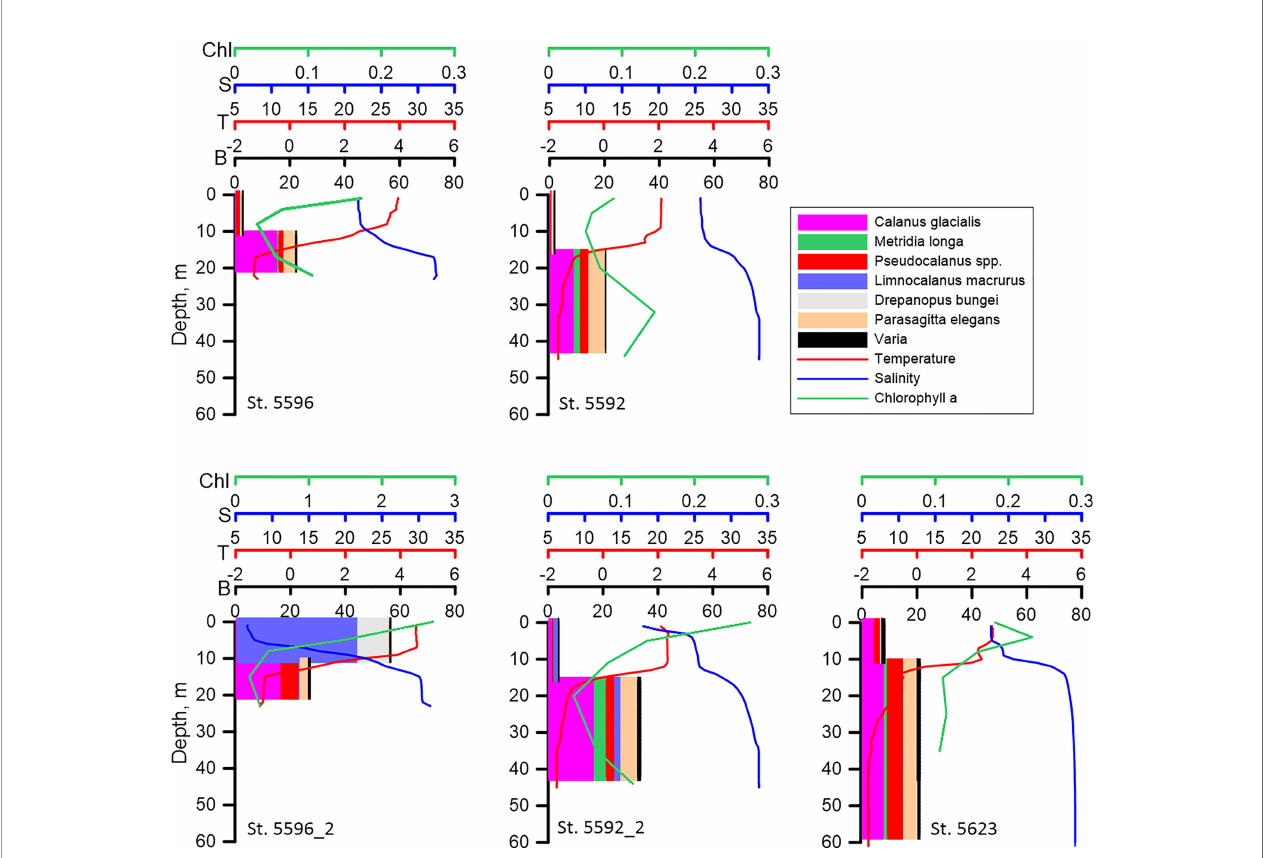
FIGURE 6 | Vertical distribution of biomass of the dominant species (B, mg DW m -3 ), temperature (T° C), salinity (S) and Chlorophyll a (Chl, mg m -3 ) along the stations in fl uenced by the Lena plume. Upper panel: sampling on 2-3 September; lower panel: sampling on 14-15 September. Considerable changes in the vertical distribution of zooplankton at the repeated st. 5596_2 are